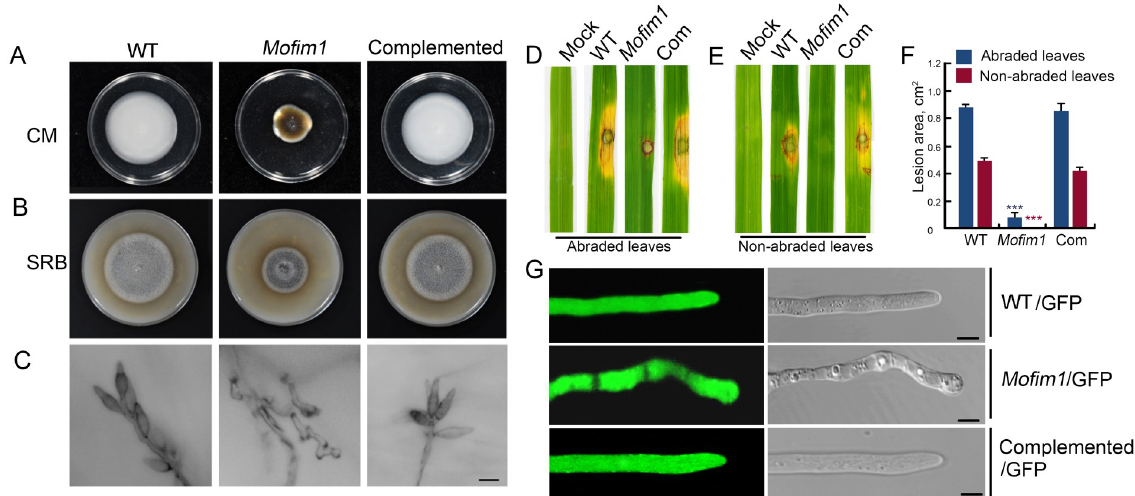
Fig 1. Growth, conidiation, hyphal morphogenesis, and plant infection defects of the Mofim1 mutant. Seven-day-old cultures of WT, Mofim1 , and the complemented strain on CM (A) and SRB medium (B) . (C) Microscopy observation of conidiation in WT, Mofim1 , and the complemented strain. Bar = 10 μ m. Pathogenicity assay using abraded (D) and non-abraded rice leaves (E) of WT, Mofim1 , and the Com (complemented) strain. The same area of each SRB culture plate from WT, Mofim1 , and the complemented strain was used to infect these rice leaves ( O . sativa cv. Nipponbare). Photographs were taken 5 d after infection. (F) Quantification of the lesion area of the rice leaves shown in (D) and (E) . Error bars represent SD ( n = 20) and asterisks ( ��� ) represent significant difference ( P < 0.001). (G) Hyphal phenotypes of GFP- labeled WT, Mofim1 , and the complemented strain. The hyphae were cultured in CM, and 100 hyphae were analyzed for WT, Mofim1 , and the complemented strain. Bars = 5 μ